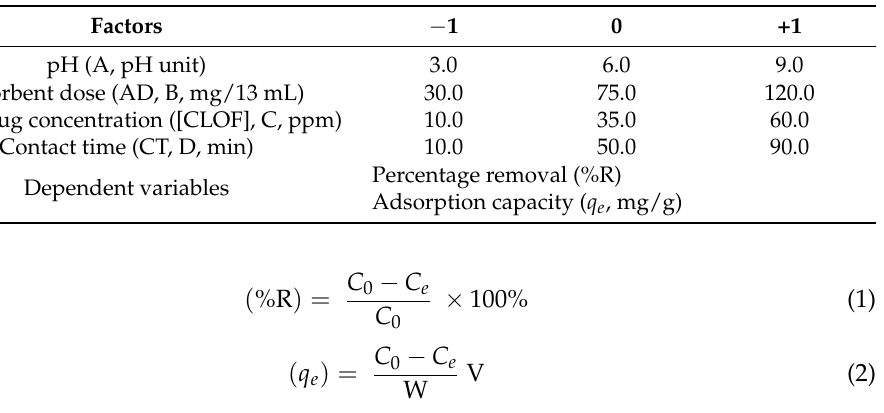
Table 2. Dependent and independent variables together with their